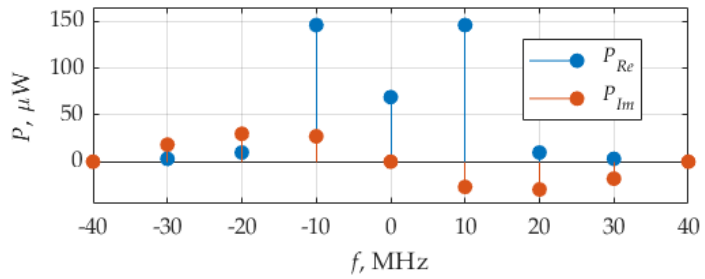
( b ) Figure 5. Diagrams of bifrequency spectrum ( a ) and CSCD ( b ) for the case of finite sum of harmonics current. Figure 5b shows the diagram of CSCD S vi ( α,f ) (21), where the weights (22) of delta functions are presented. The cyclic frequency, α , ranges from −60 to 60 MHz, the fre-